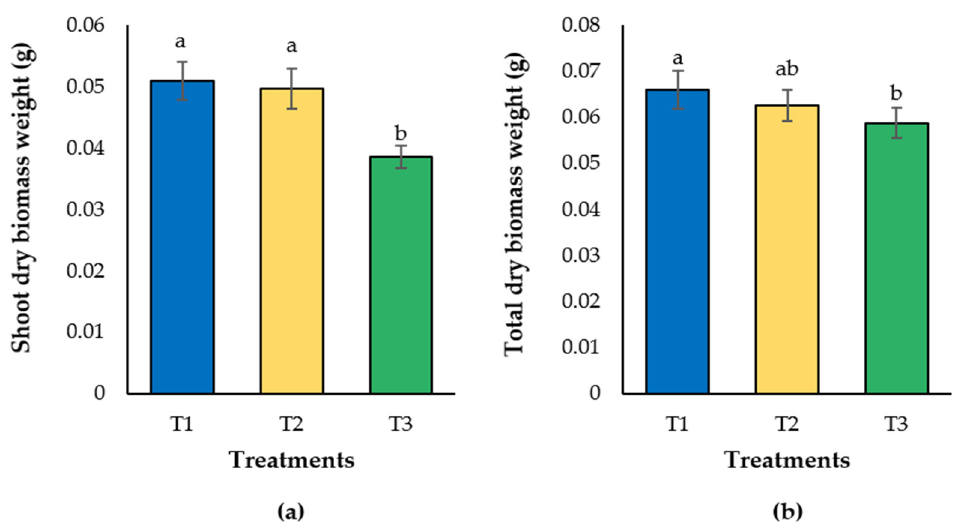
Figure 3. Shoot ( a ) and total dry biomass weight ( b ) of lulo ( Solanum quitoense Lam.) seedlings grown in different combinations of peatmoss and compost. Columns are means of 10 seedlings per treatment, randomly selected, one per repetition. Bars on the columns indicate standard deviation. Different letters on the columns in each subfigure indicate significant differences among treatments.